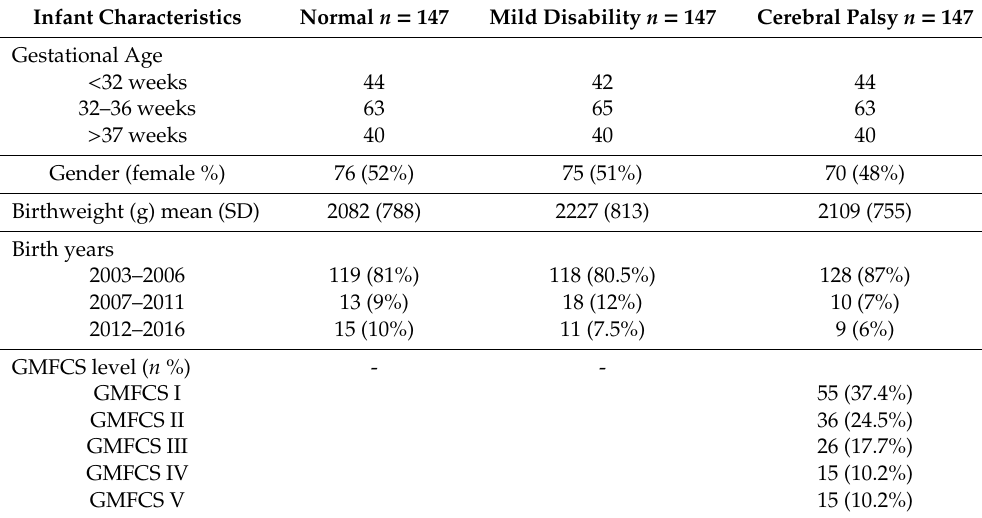
Table 1. Characteristics of